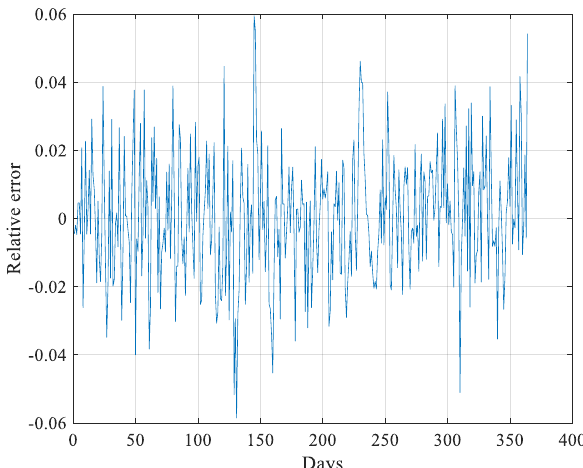
Figure 12. Relative error diagram of original signal .